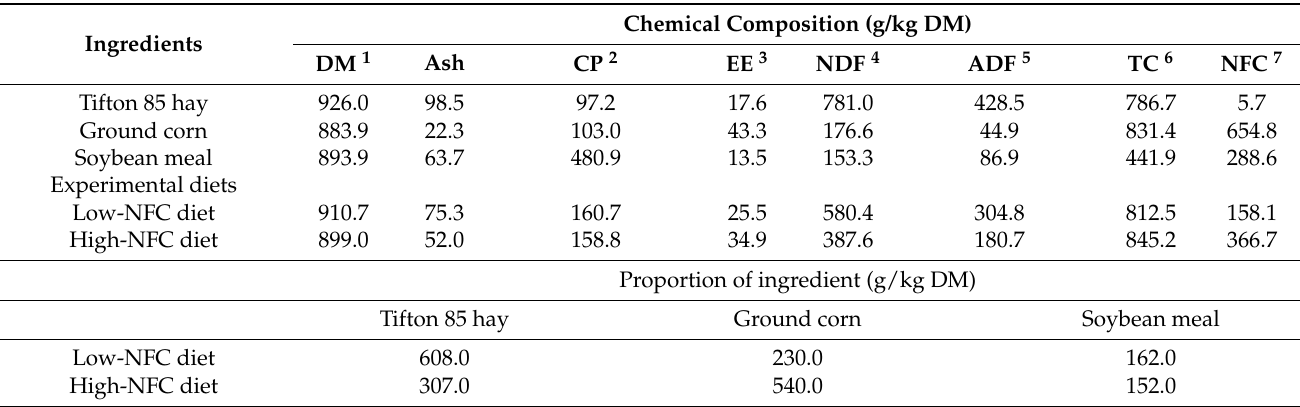
Table 1. Chemical composition of ingredients and experimental